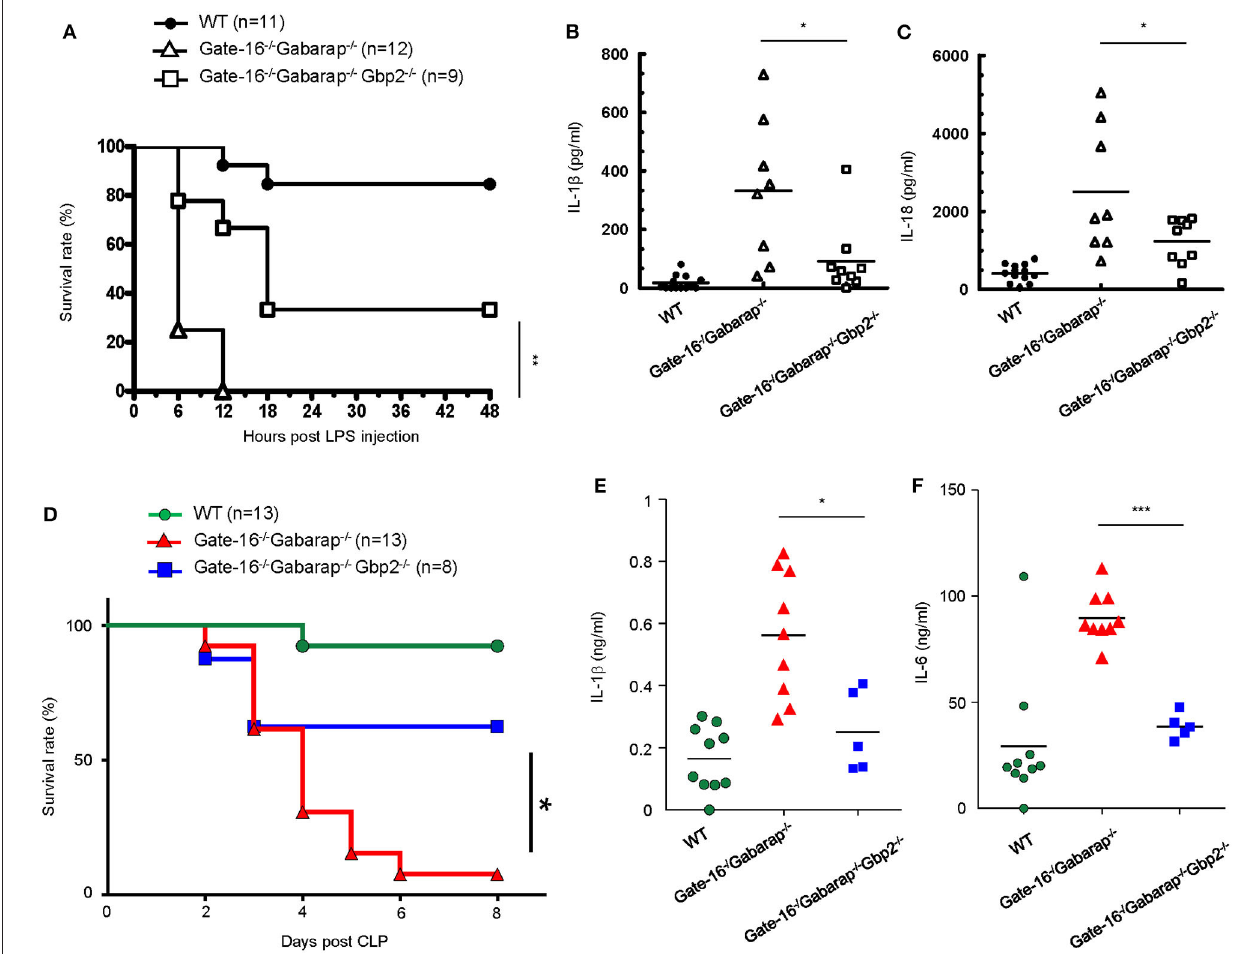
FIGURE 6 | GBP2-dependent high mortality in Gate-16 − / − Gabarap − / − mice during sepsis. (A) Wild-type (WT: n = 11), Gate-16 − / − Gabarap − / − ( n = 12), and Gate-16 − / − Gabarap − / − Gbp2 − / − ( n = 9) mice were i.p. injected with 10 mg/kg body weight of poly(I:C) and then 7h later i.p. injected with LPS (0.1 mg/kg body weight). Morbidity and mortality were observed for 48h at 6h intervals. (B,C) Wild-type (WT), Gate-16 − / − Gabarap − / − , and Gate-16 − / − Gabarap − / − Gbp2 − / − mice were i.p. injected with 10 mg/kg body weight of poly(I:C) and then 7h later i.p. injected with LPS (0.1 mg/kg body weight). Sera were taken 3h after LPS injection from WT ( n = 13), Gate-16 − / − Gabarap − / − ( n = 8) or Gate-16 − / − Gabarap − / − Gbp2 − / − (n = 9) mice for IL-1 β (B) and IL-18 (C) serum concentrations were measured by ELISA. (D) CLP was performed in wild-type (WT: n = 13), Gate-16 − / − Gabarap − / − ( n = 13), and Gate-16 − / − Gabarap − / − Gbp2 − / − ( n = 8) mice. Morbidity and mortality were observed for 8 days at 1 day intervals. (E,F) CLP was performed in wild-type (WT; n = 10), Gate-16 − / − Gabarap − / − ( n = 9) and Gate-16 − / − Gabarap − / − Gbp2 − / − ( n = 5) mice. Peritoneal fluids were taken 16h after CLP from the mice for IL-1 β (E) and IL-6 (F) serum concentrations